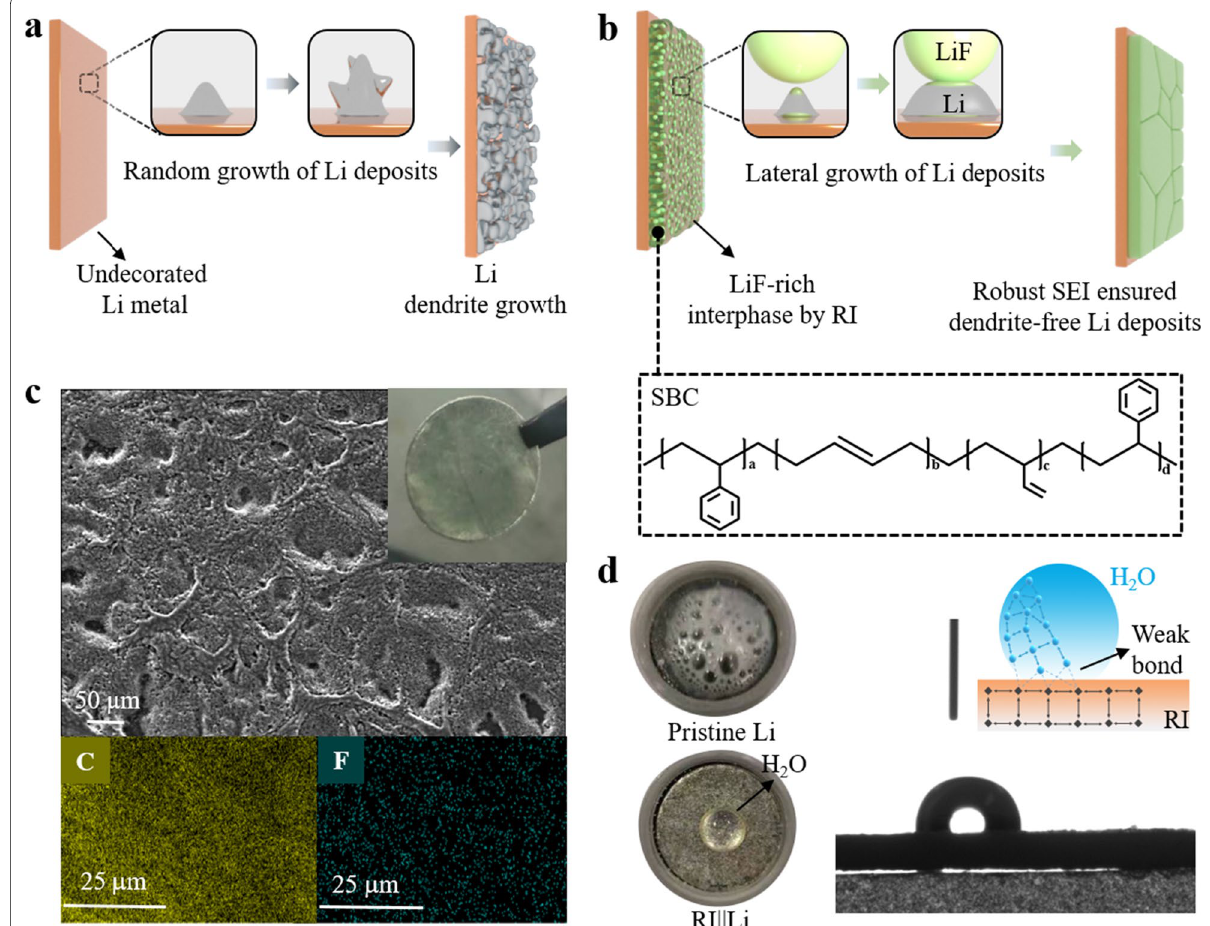
Fig. 1 a Schematic diagram of Li deposition on the surface of undecorated Li and b RI||Li, the molecular structure of SBC is listed at the bottom of plane b . c SEM image of RI||Li and corresponding element mapping of C and F, the optical image of RI||Li is inserted. d Optical images of pristine Li and RI||Li poured by H 2 O droplet, the left is corresponding contact angel and corresponding schematic